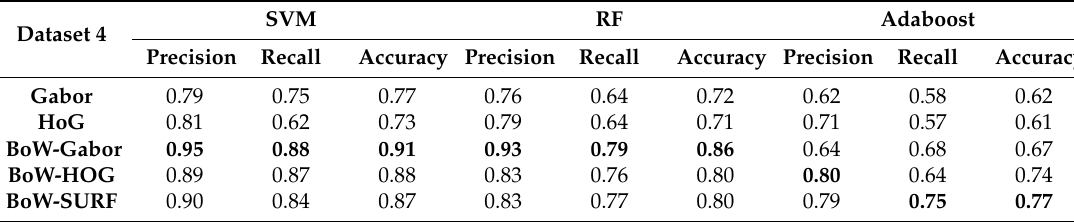
Table 6. Performance of feature descriptors when associated with different learning algorithms for dataset 4 (COM 3109 ) comprising patches from UAV, Pictometry, and street-view images (training samples = 2176, testing samples = 933).